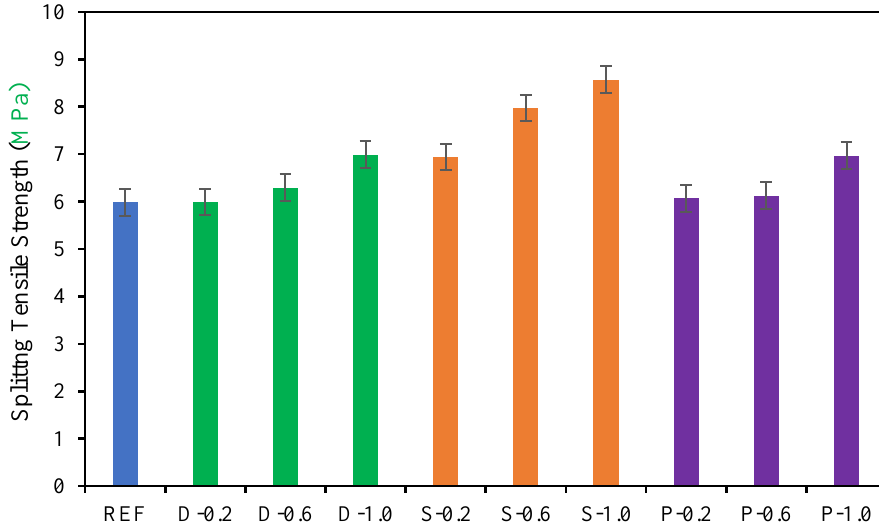
Figure 8. Splitting tensile strength of fibrous concrete samples.